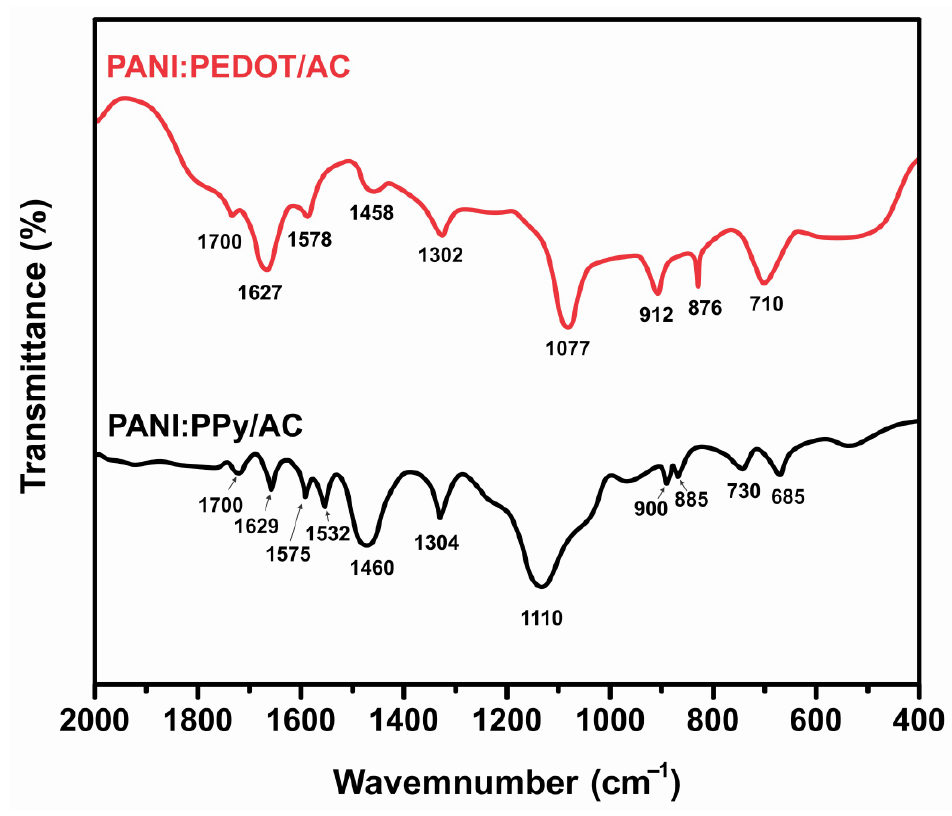
Figure 2. FTIR Spectra recorded for PANI:PPy/AC film and PANI:PEDOT/AC film.